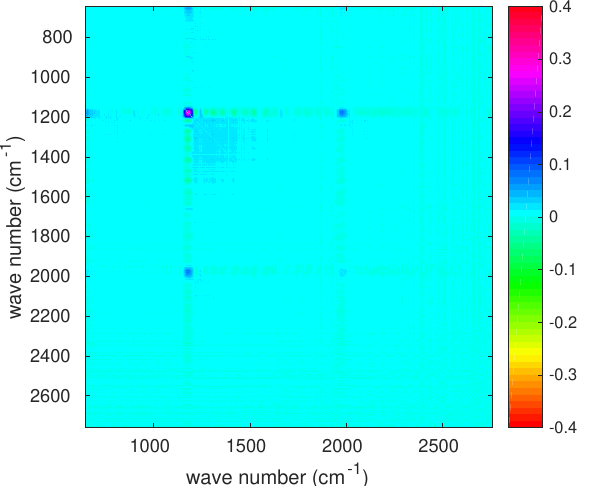
Figure 2. IASI-C S ε transformed to correlation matrix; the diagonal has been subtracted to better identify correlation